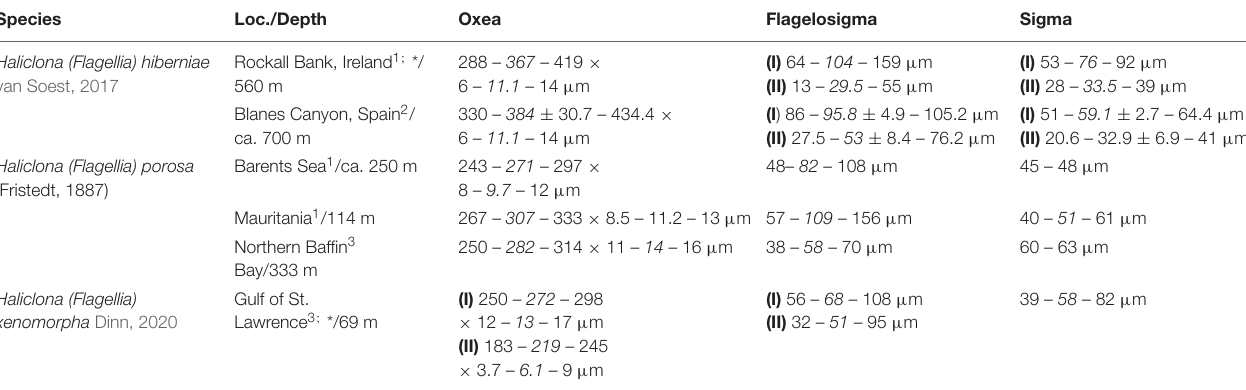
Numbers after Locality indicate the reference for each sample; * indicates this is the holotype of the species. (1) van Soest (2017); (2) Present study; (3) Dinn (2020).